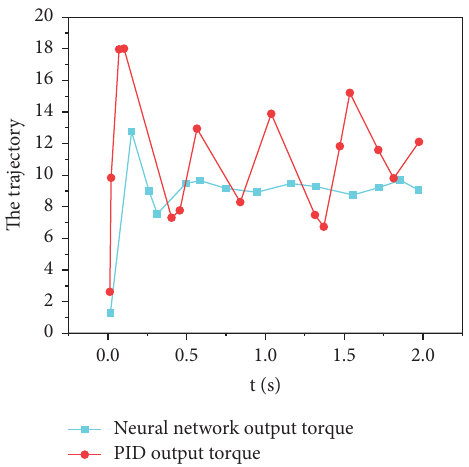
Figure 6: Torque control of robot arm 3 (with external